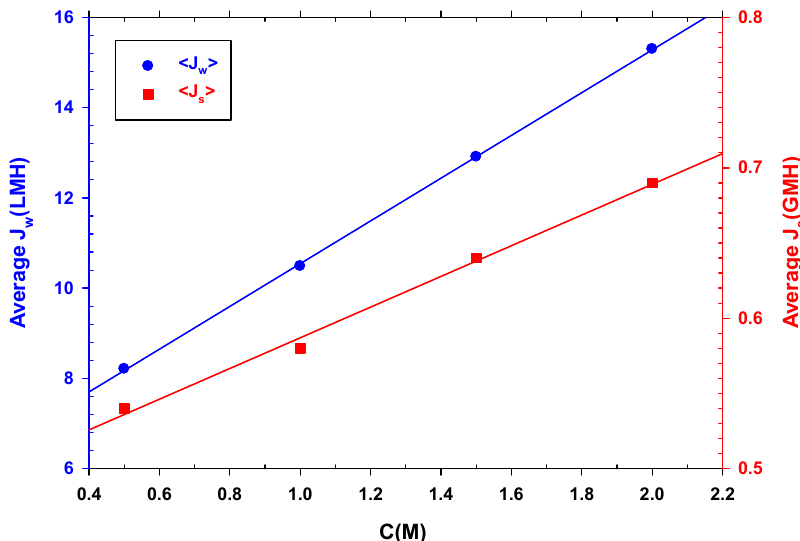
Figure 8. Average water flux (left side) and average reverse salt flux (right side) versus NaCl con- centration . NaCl